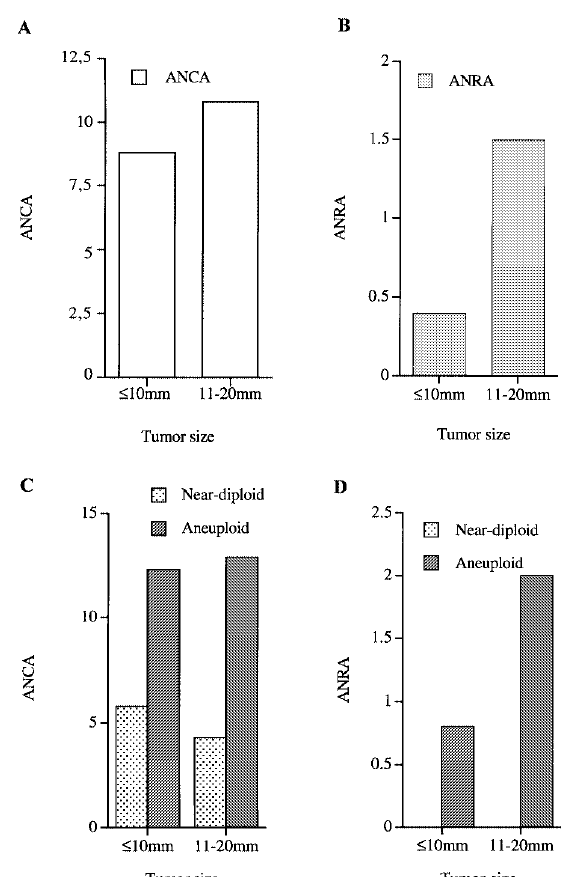
Fig. 3. (A) Average number of copy alterations (ANCA) and (B) av- erage number of regional amplifications (ANRA) in T1b ( (cid:1) 10 mm) and T1c (11–20 mm) breast adenocarcinomas, and in relation to tu- mor size and DNA-ploidy (C,